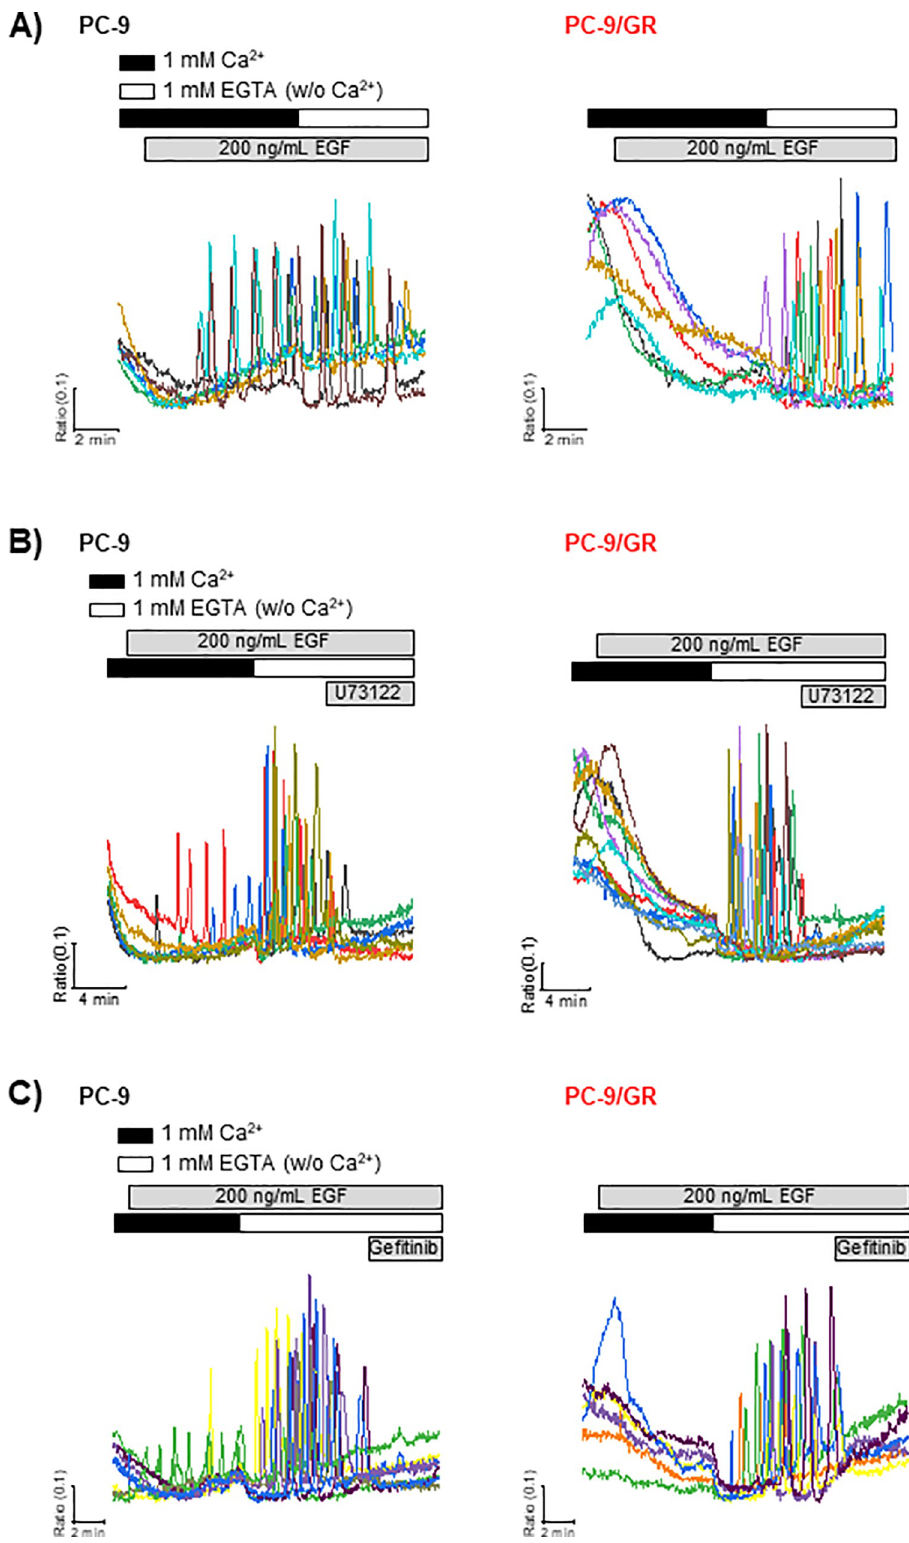
Fig 2. Characterizations of low [Ca 2+ ]e-mediated [Ca 2+ ]i oscillations. PC-9 and PC-9/GR cells loaded with Fura-2/ AM were used to determine [Ca 2+ ]i in response to low [Ca 2+ ]e, U73122, and gefitinib. (A) Induction of [Ca 2+